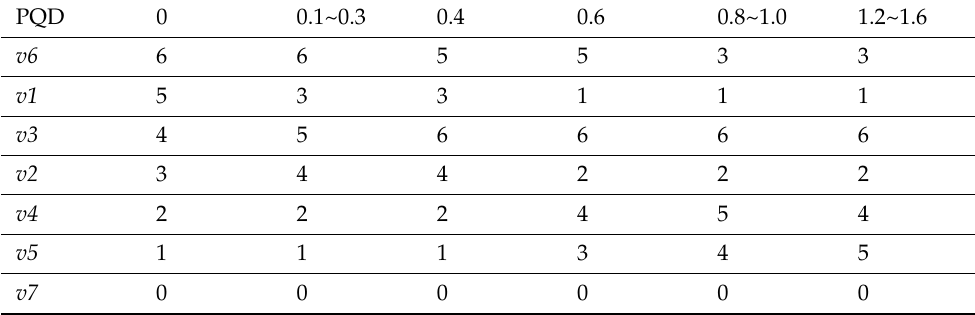
Table 8. Scores of harmonic variations.